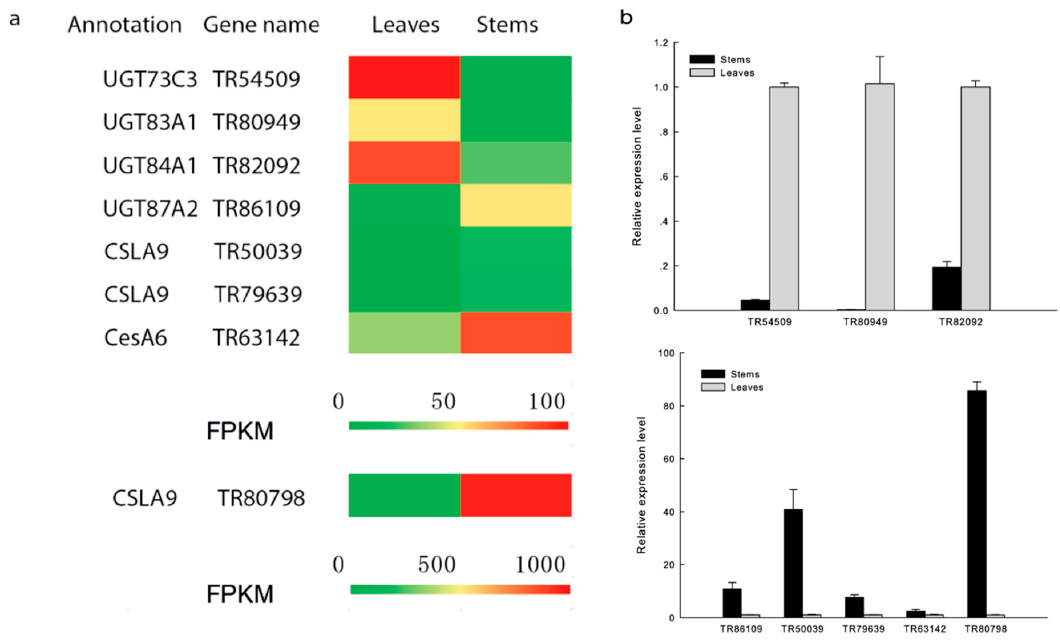
Figure 3. Comparison of polysaccharide biosynthesis candidate gene expression in leaves and stems of D. officinale . ( a ) Heat map of candidate gene expression profiles from SGS data; ( b ) RT-qPCR analysis of candidate genes in leaves and stems. Data are shown as means ± standard error ( n = 3).